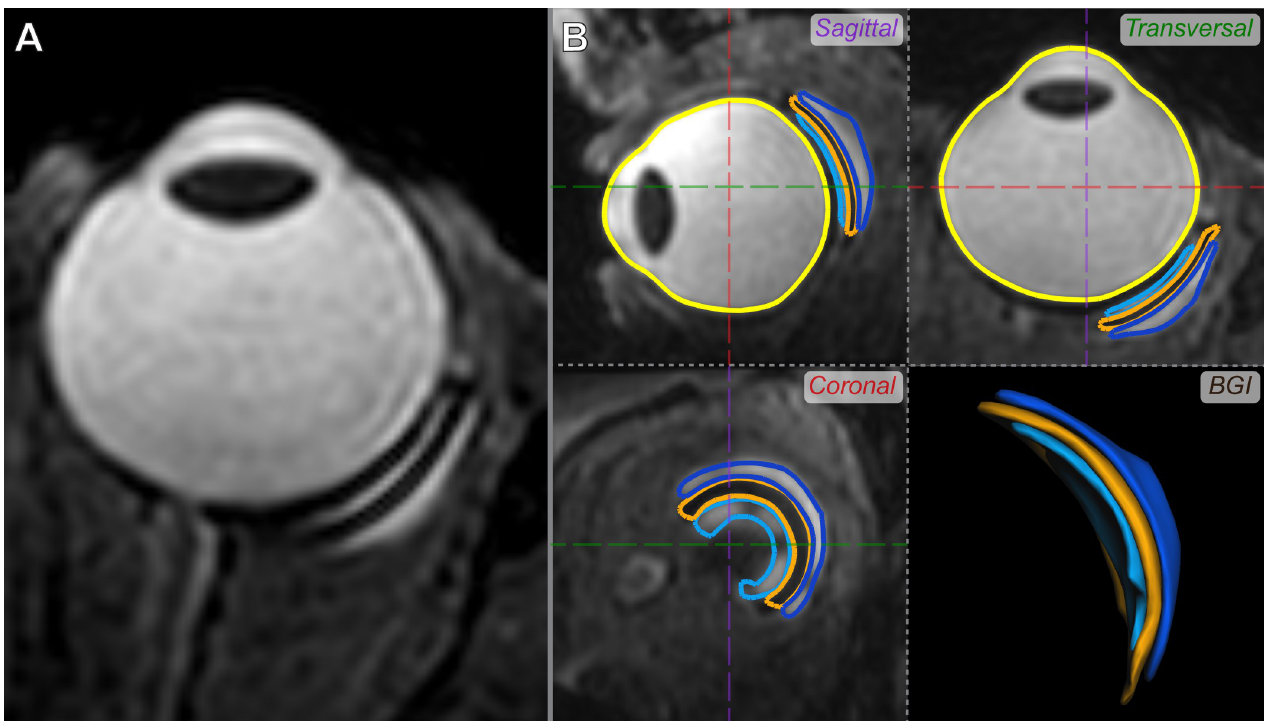
Fig 1. Three-dimensional MRI assessment of the BIG. A) Typical 3D T2-weighted MR-image of an eye with a BGI. B) Volumes segmented from that same MR-Image in three orthogonal reformats (sagittal, transversal and coronal), allowing for an accurate and 3D assessment of the bleb and its relation to the eye. Displayed are the inner bleb (dark blue) , BGI (orange) and outer bleb (light blue) . A segmentation of the eye (yellow) is also shown for reference.